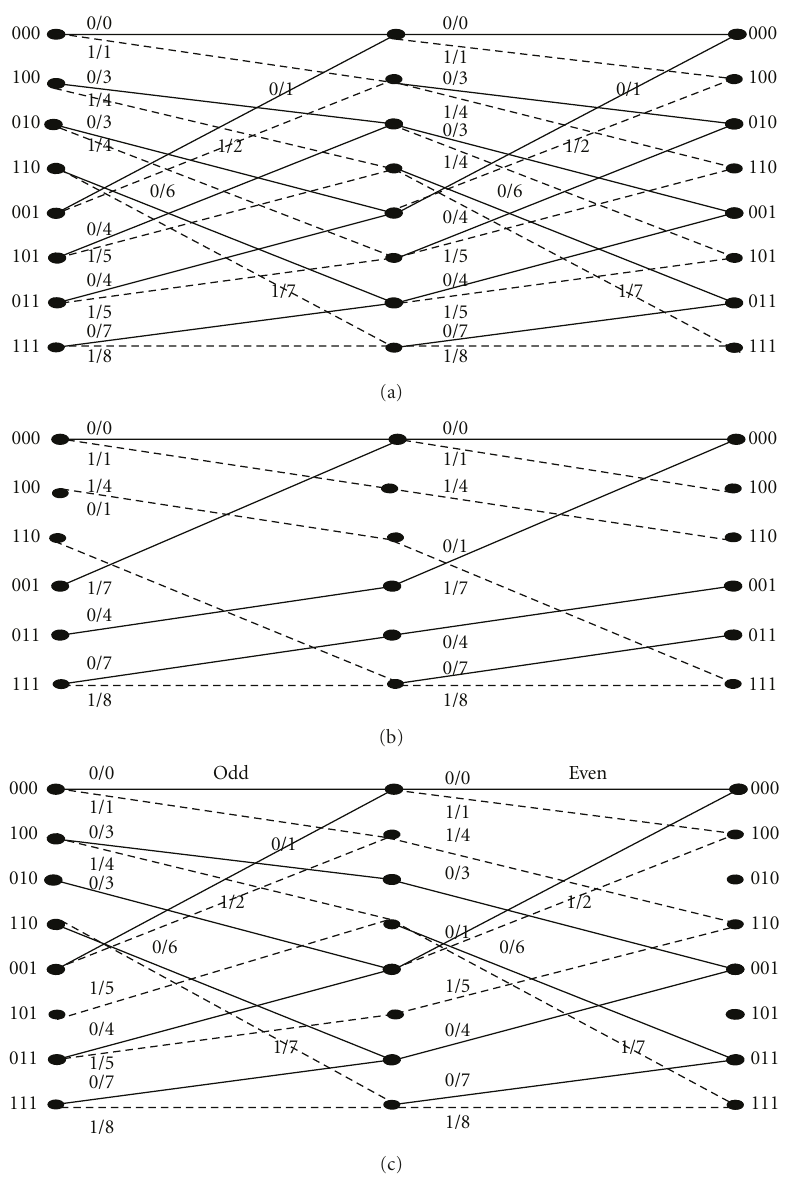
Figure 7: Trellis diagram. (a) EPRII channel. (b) EFMPlus-coded EPRII channel. (c) TMTR-coded EPRII